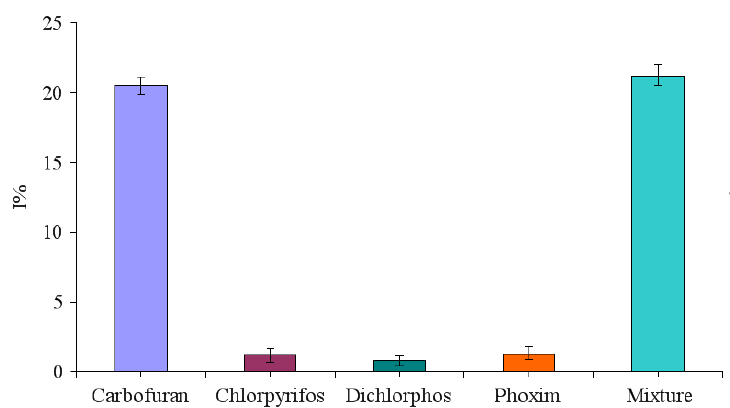
Figure 6. Relative change of current response of the immunsensor to 50 ng/mL carbofuran, 50 ng/mL chlorpyrifos, 50 ng/mL dichlorphos, 50 ng/mL phoxim and the mixture containing 50 ng/mL carbofuran, 50 ng/mL chlorpyrifos, 50 ng/mL dichlorphos and 50 ng/mL phoxim.